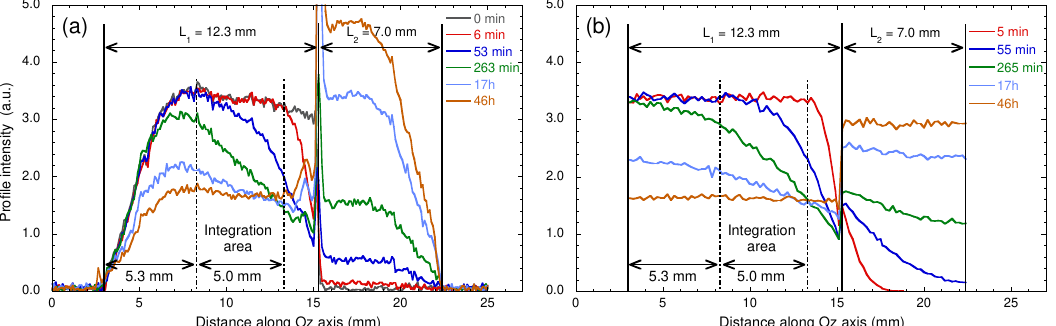
Figure 16. Time evolution of the water concentration profiles: ( a ) measured by MRI after the addition of bulk heavy water on the top of the water saturated sample and ( b ) obtained by numerical simulations of Brownian dynamics (see the text). Reprinted with permission from [29]. Copyright (2018) American Chemical